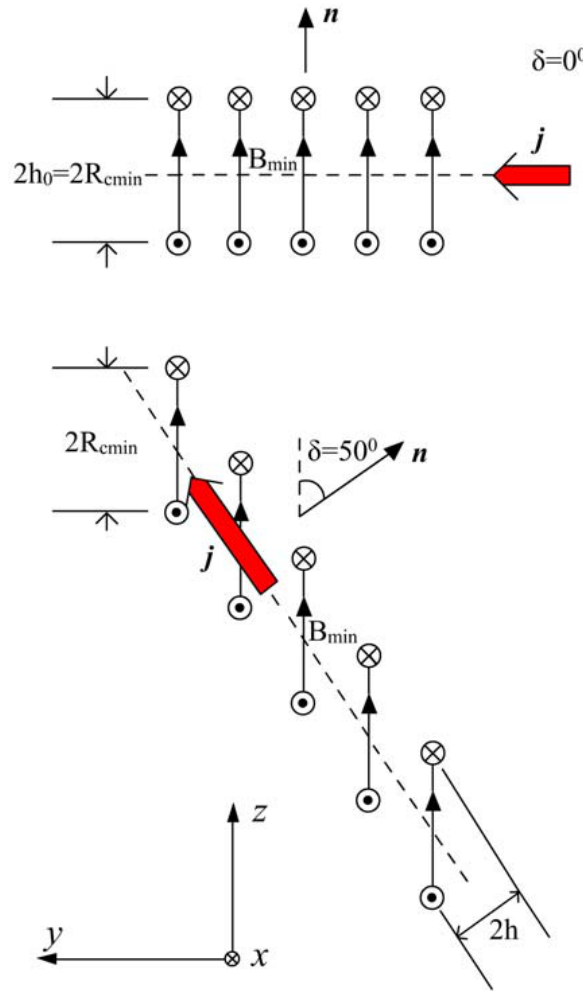
Fig. 5. The transformation from the normal Harris type current sheet (upper panel) to the tilted current sheet (lower panel) through Fig. 5 The transformation from the normal Harris type current sheet (upper panel) the slipping of the to the tilted current sheet (lower panel) through the slipping of the MFLs.